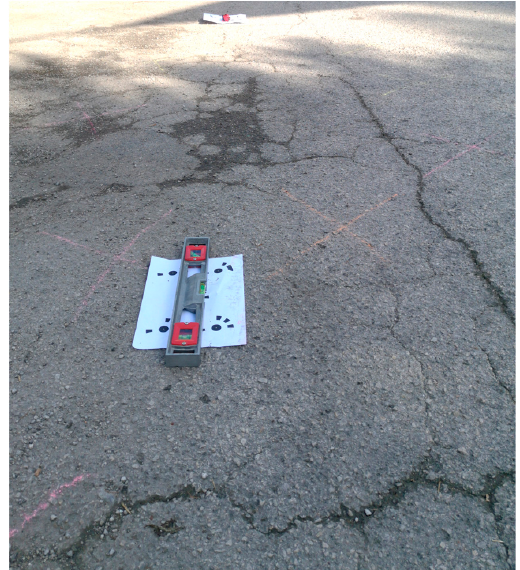
Figure 4. Distressed section 1.